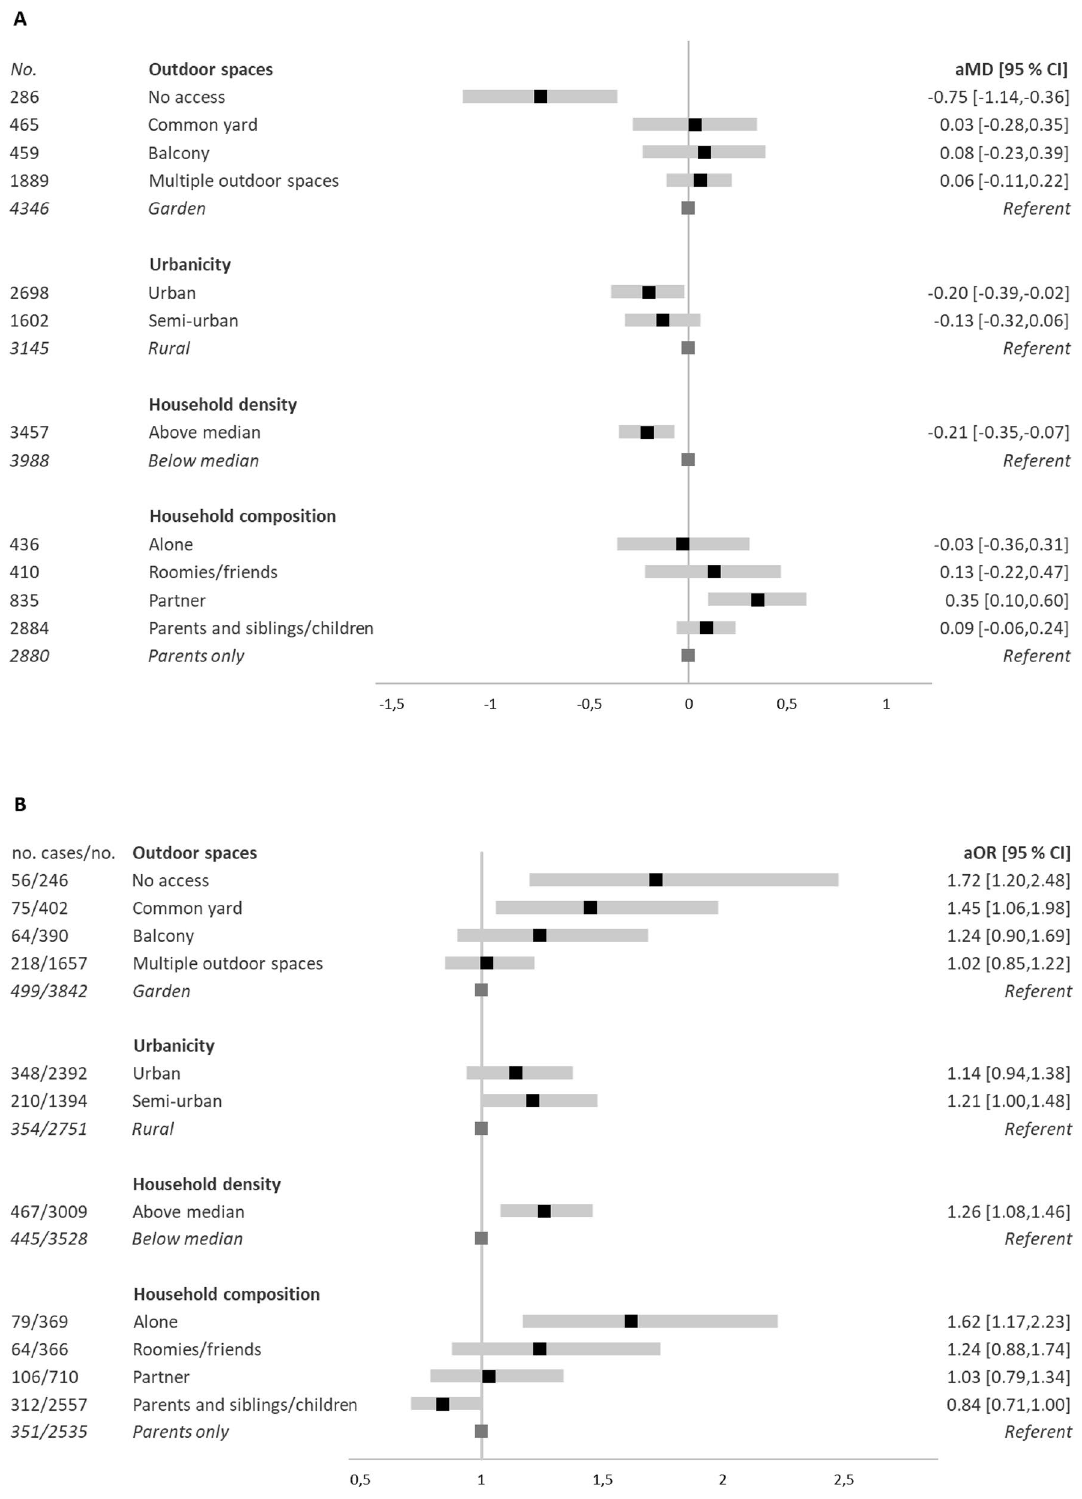
Figure 4. Changes in mental well-being ( A ) and onset of low mental well-being ( B ), according to housing conditions. aMD Adjusted Mean Difference, aOR Odds Ratios, CI Confidence Intervals. aMD and 95% CI and aOR and 95% CI are presented. Population at risk of developing low mental well-being: No. (6537). Adjusted model 2: adjusted for age, sex, current education, part-time work, moving, geographical region, and mutually adjusted for housing